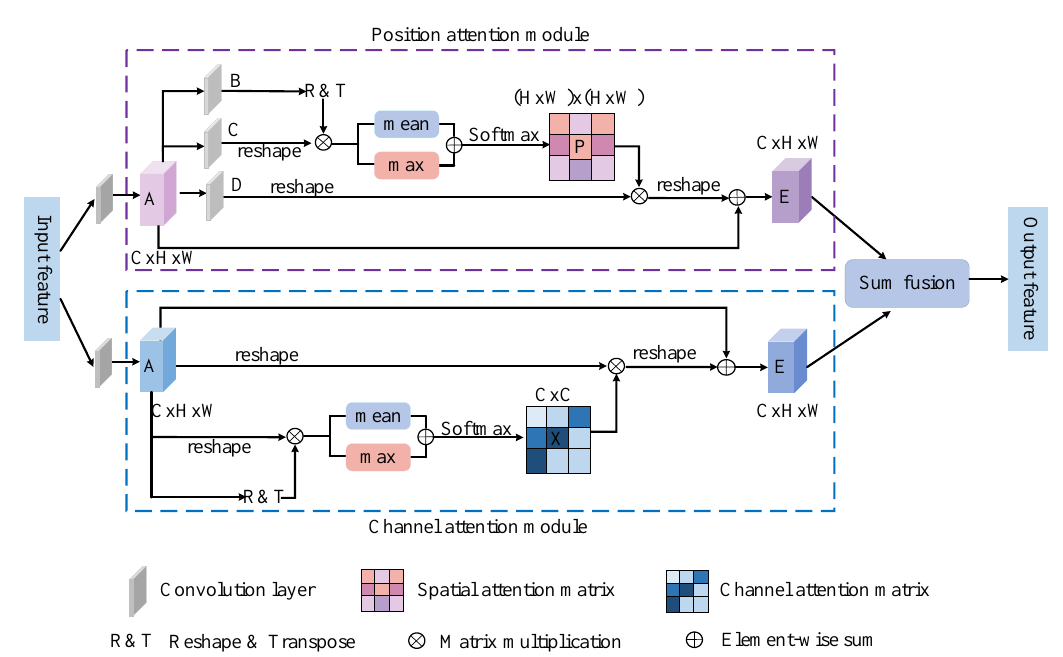
Figure 2. The detail of the IDA module. The upper part highlights the position attention module, and the lower part highlights the channel attention module.